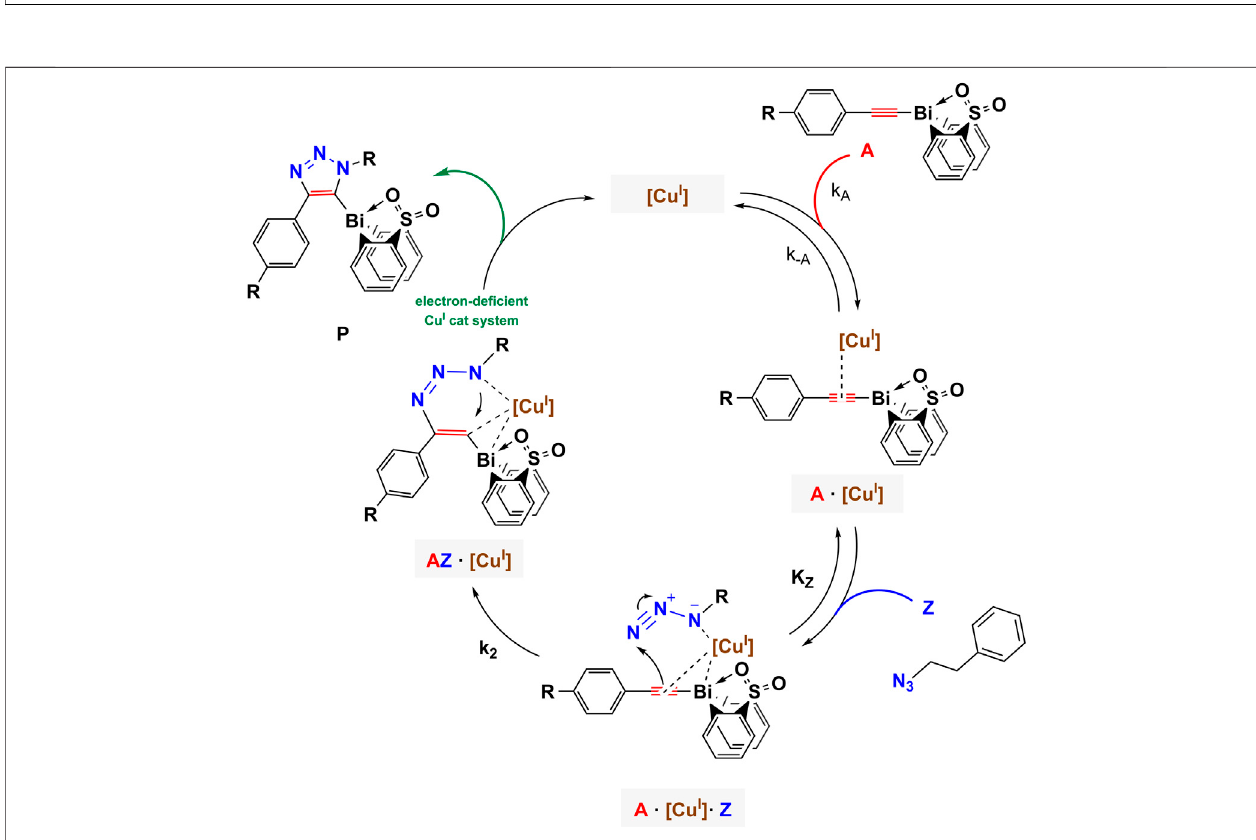
SCHEME1| Proposedmechanisticmodelofazide-bismuth(III)acetylidecopper(I)-catalyzedcycloadditionreaction.Theelectronicnatureofthealkynesubstrateis expected to directly in fl uence the kinetics of the catalytic